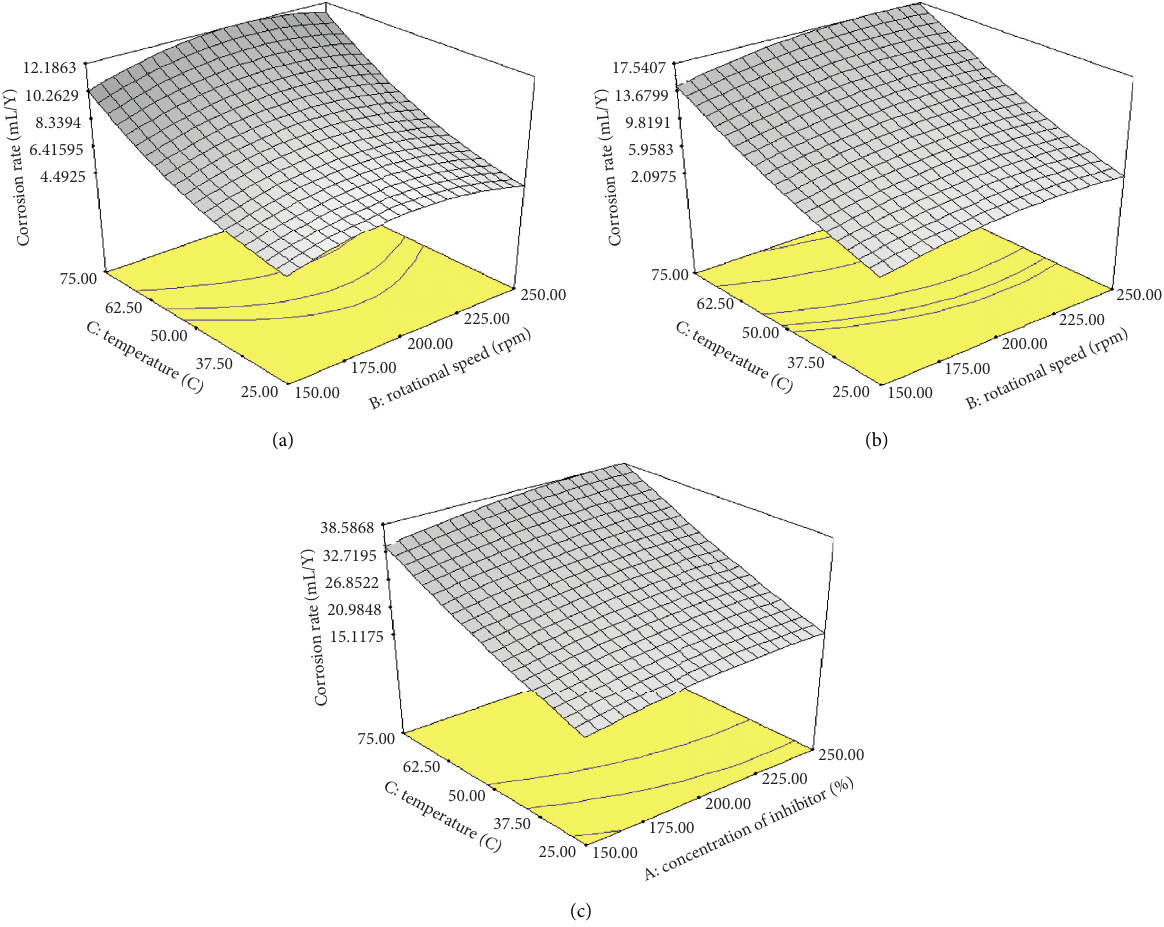
Figure 11: 3D plot of corrosion rate as a purpose of rotational speed and temperature at the inhibitor loads (a) 10%, (b) 7.5%, and (c) 5%.